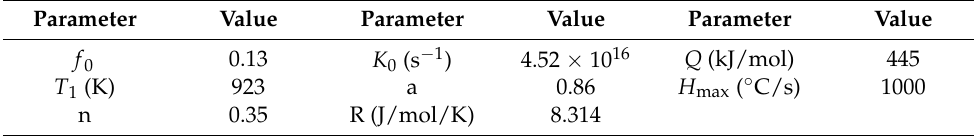
Table 2. Material constants of a phase transformation volume fraction prediction